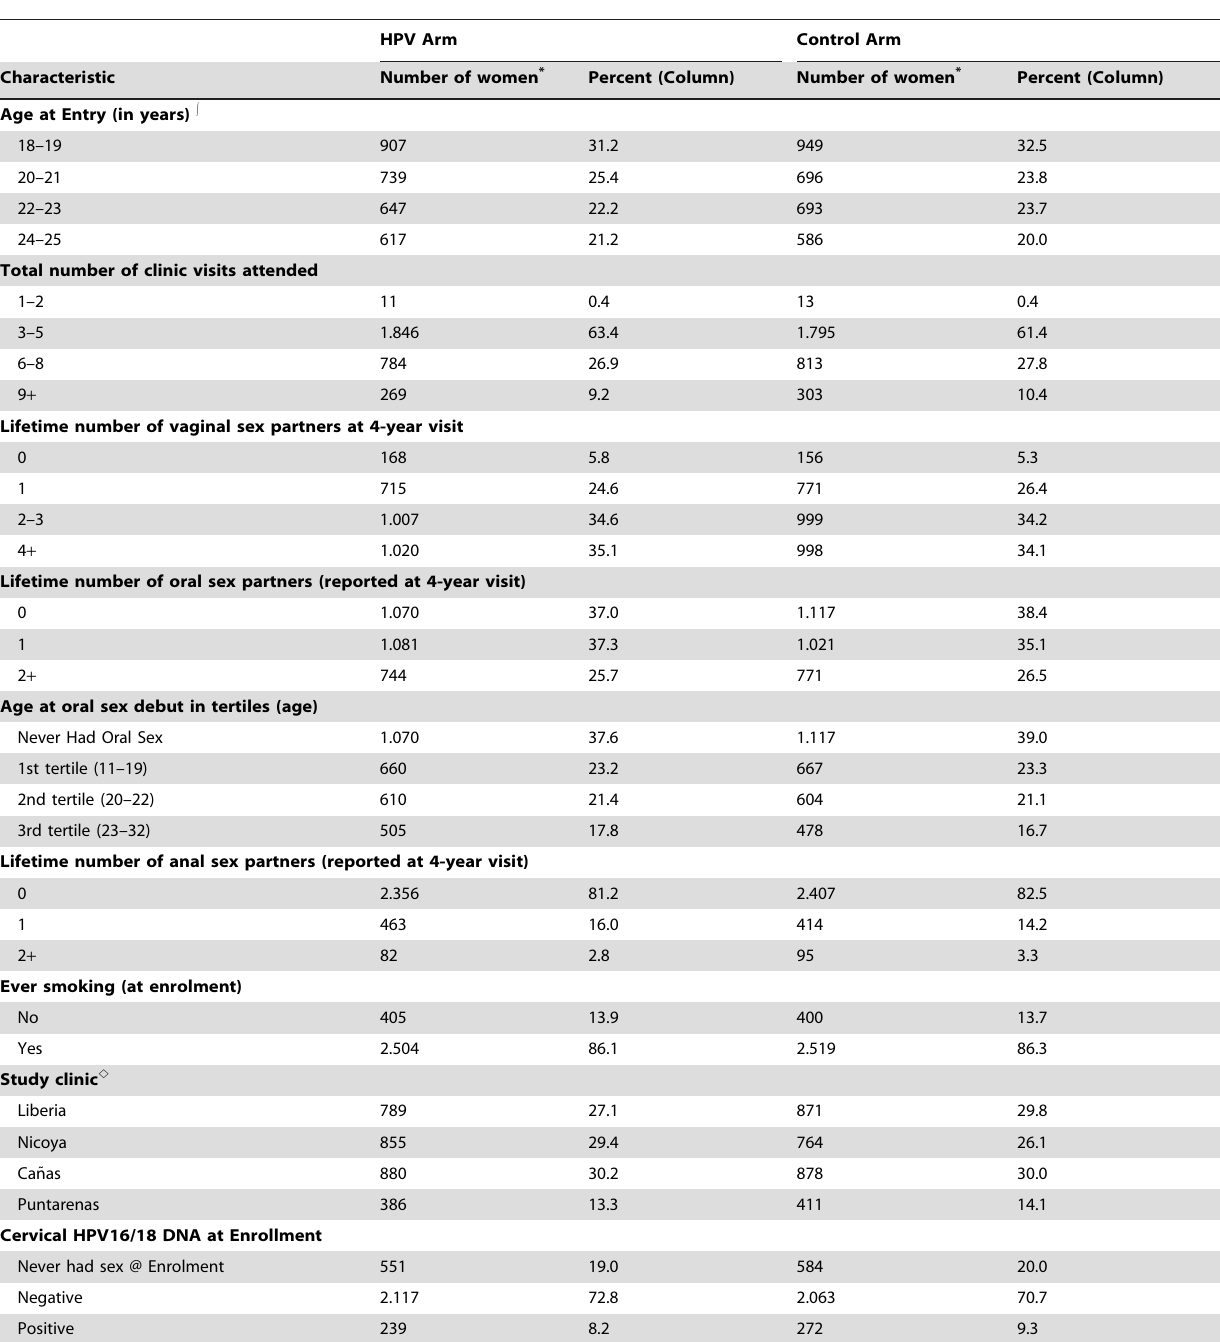
Table 2. General characteristics of the analytic population by vaccination arm (N